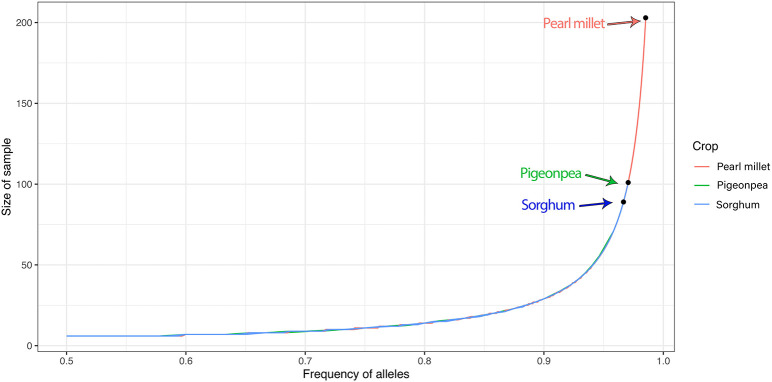
Plot of seed sample sizes needed for regeneration vs. allelic frequencies to preserve 95% of alleles showing the exponential increase in the size of sample required with the decrease in the alternate allele frequency. The arrows represent the highest values of seed sample size estimated in sorghum, pigeonpea, and pearl millet.